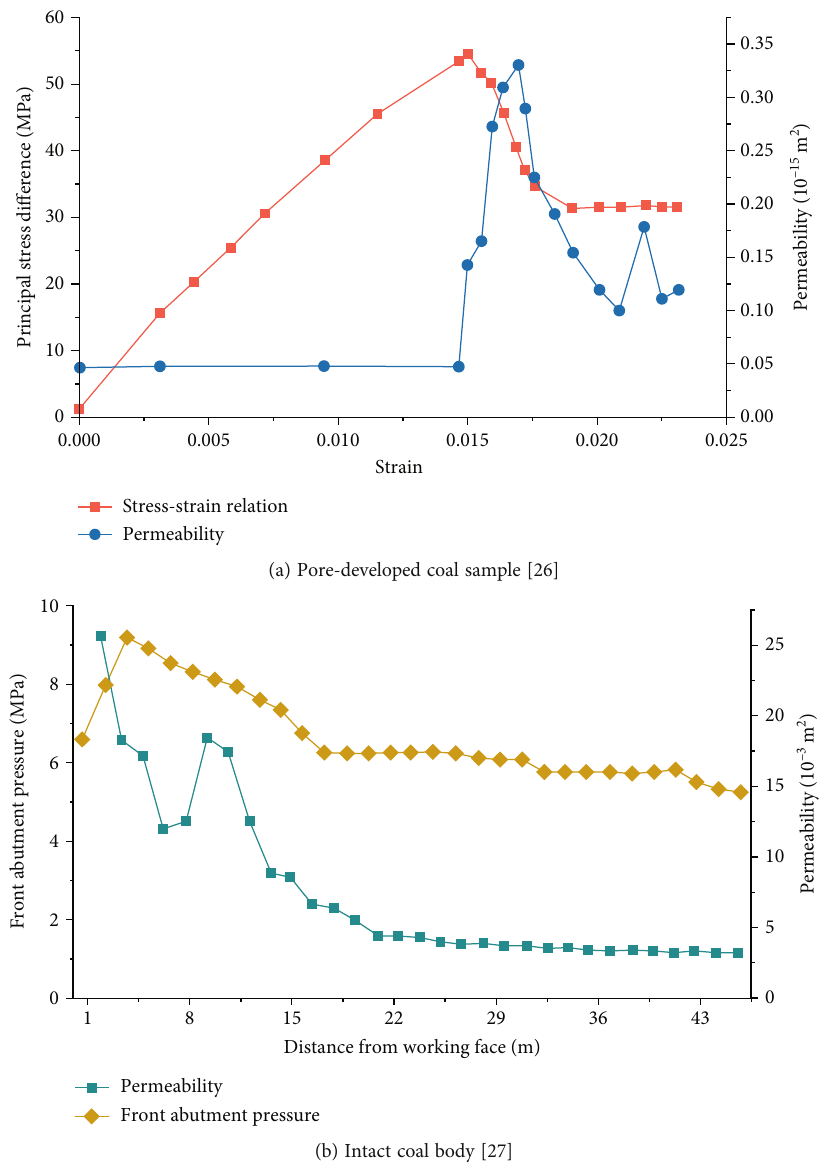
Figure 4: Variation curve of coal